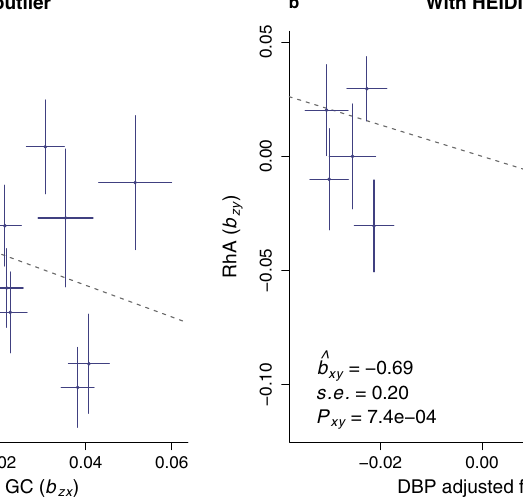
26,000, bin #11=2823/26,078. The vertical bars represent the 95% con fi dence interval for the bins (except for the sixth bin which is the reference category). A two-tailed P value wasestimates for the odds ratio ofeach bin ofinterest. P values for lower PRS categories (bins 1 – 5) were 8.9×10 − 13 , 3.7×10 − 8 , 0.48, 0.83, and 0.21, respectively. P valuesforhigherPRScategories(bins7 – 11)were2.1×10 − 4 ,3.2×10 − 5 , 5.1×10 − 17 , 2.7×10 − 21 , and 6.3×10 − 25 , respectively. The Bonferroni corrected threshold was 0.005 (=